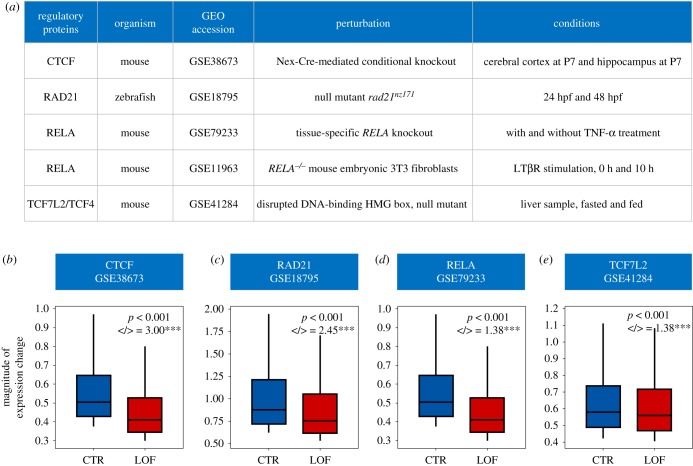
Perturbing regulatory proteins affects the magnitude of gene expression changes. (a) Gene expression datasets used to validate the influence of regulatory proteins on GEP. (b–e) Loss of function of four regulatory proteins predicted to promote expression plasticity reduced the magnitude of gene expression changes. Absolute log2-fold changes of gene expression between two conditions were used to approximate changes in GEP. Box plots show magnitudes for the mostly dynamically expressed genes (top 20%) in control (CTR) and loss of function (LOF) mutants. Gene numbers for each dataset are: n = 1817 for CTCF (b), n = 1130 for RAD21 (c), n = 675 for RELA (d) and n = 2114 for TCF7L2 (e). </> indicates the ratio of genes showing lower change magnitude to those showing higher magnitude. Only genes that exhibited expression changes in the same direction between two conditions (co-upregulation or co-downregulation) were considered. *** denotes a ratio significantly different from expected (Fisher's exact test, p < 0.001).